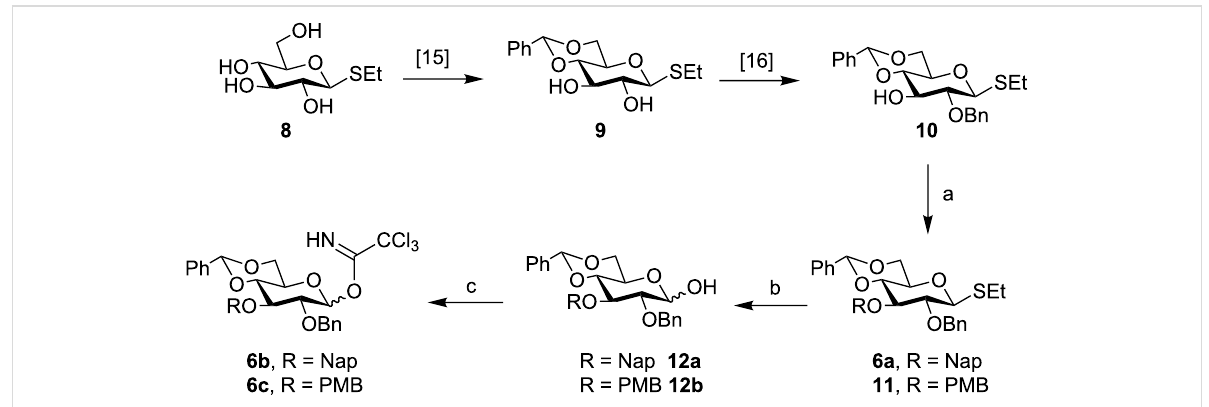
Scheme 1: Preparation of D-glucosyl donor 6 . Reaction conditions: a) NapBr/PMBCl, NaH, DMF, rt, 12 h, 90% ( 6a ), 80% ( 11 ); b) TCCA, CH 3 COCH 3 / H 2 O (4:1), rt, 85% ( 12a ), 89% ( 12b ); c) CCl 3 CN, DBU, DCM, 0 °C, 93% ( 6b ), 90% ( 6c ).